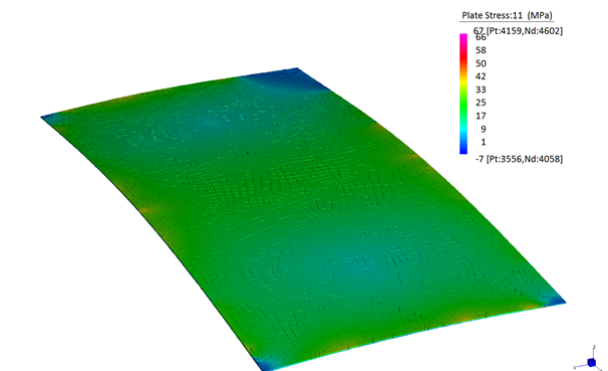
Fig. 11 Main stresses after